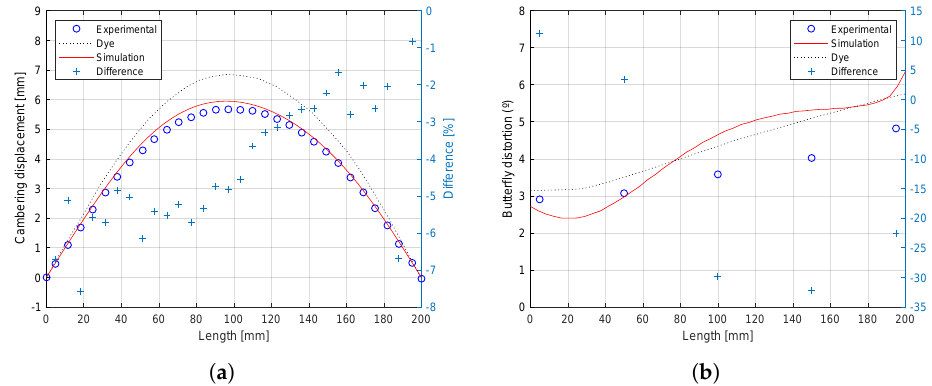
Figure 10. Predicted vs. experimental: ( a ) cambering distortion and ( b ) butterfly